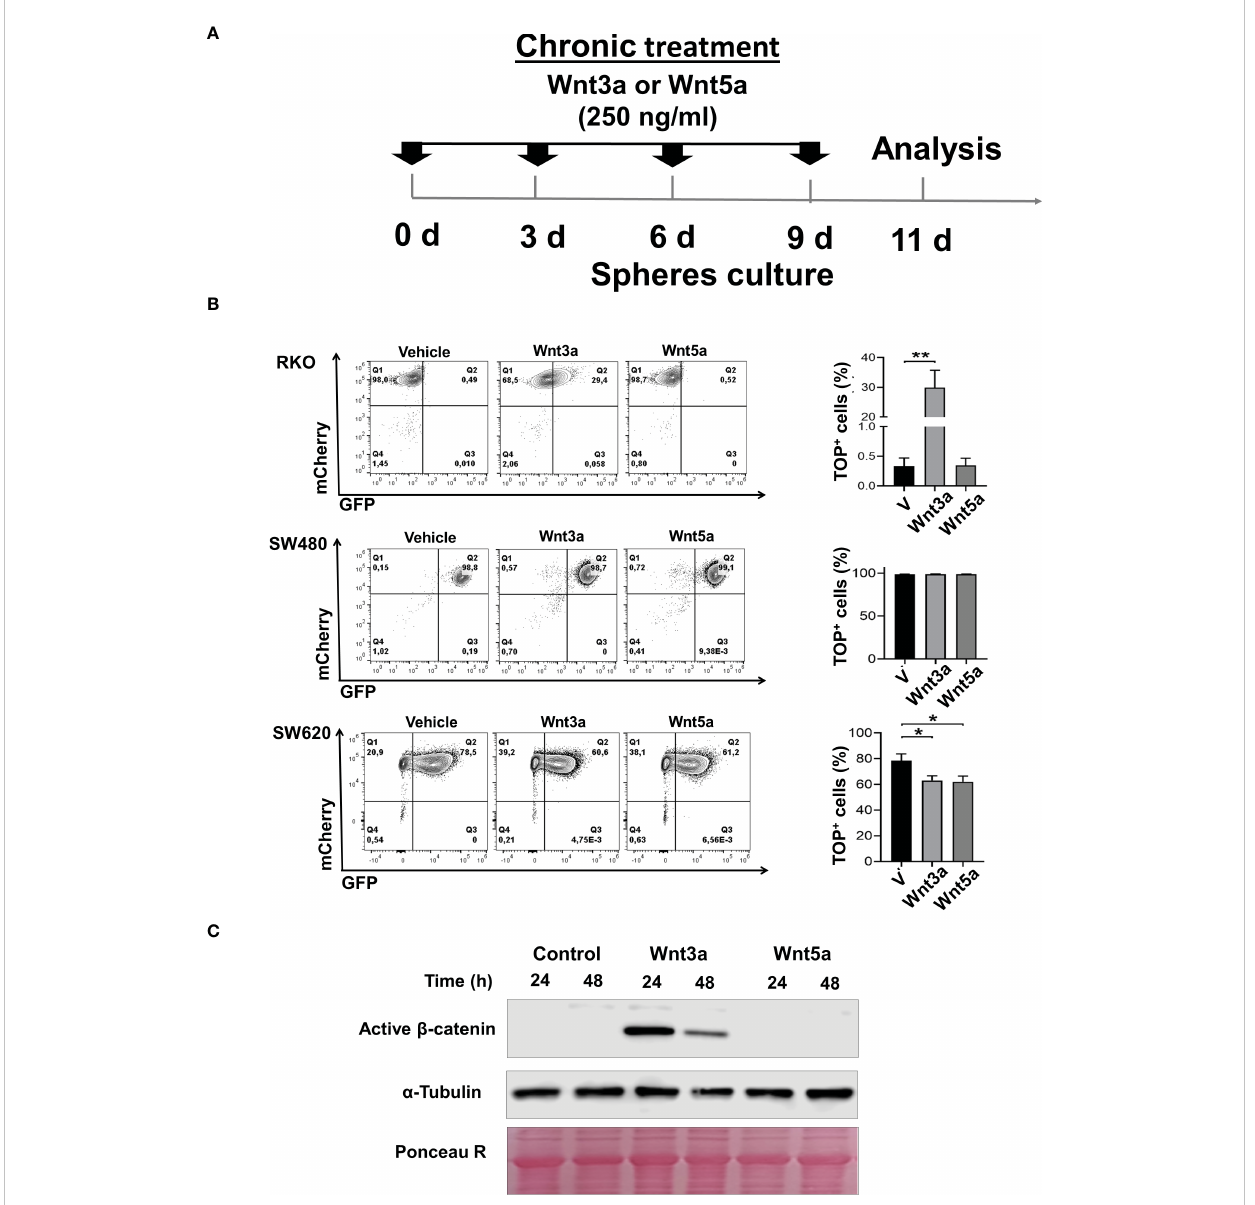
FIGURE 2 Wnt3a but not Wnt5a stimulates b -catenin transcriptional activity in RKO and SW620 sphere cells. (A) . Experimental scheme for spheres stimulation of RKO TOP/GFP , SW480 TOP/GFP , and SW620 TOP/GFP cells with Wnt3a (250ng/ml) or Wnt5a (250ng/ml). Transduced cells are indicated as mCherry+ cells (B) . Density plots were measured by fl ow cytometry (left panel), and the quanti fi cation of the percentage of GFP + cells of RKO TOP/GFP , SW480 TOP/GFP , and SW620 TOP/GFP from spheres chronically treated with Vehicle, Wnt3a or Wnt5a are shown (right panel). (C) Analysis of active form of b -catenin by Western blot performed in samples obtained from RKO spheres (second generation) in the absence or the presence of Wnt3a or Wnt5a at the indicated times. a -Tubulin and Ponceau Red were used as loading controls. Data are represented as the mean values ± SEM of at least three independent experiments. Statistical analysis was performed using one-way ANOVA followed by Bonferroni´s multiple comparisons. *p<0.05;